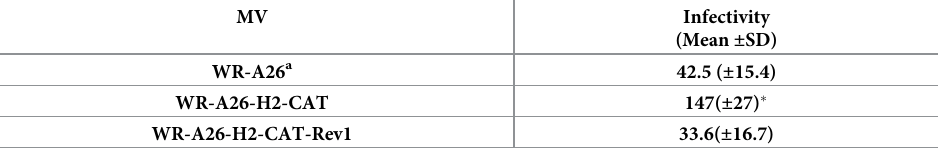
Table 3. MV particle infectivity of WR-A26, WR-A26-H2-CAT and the revertant virus